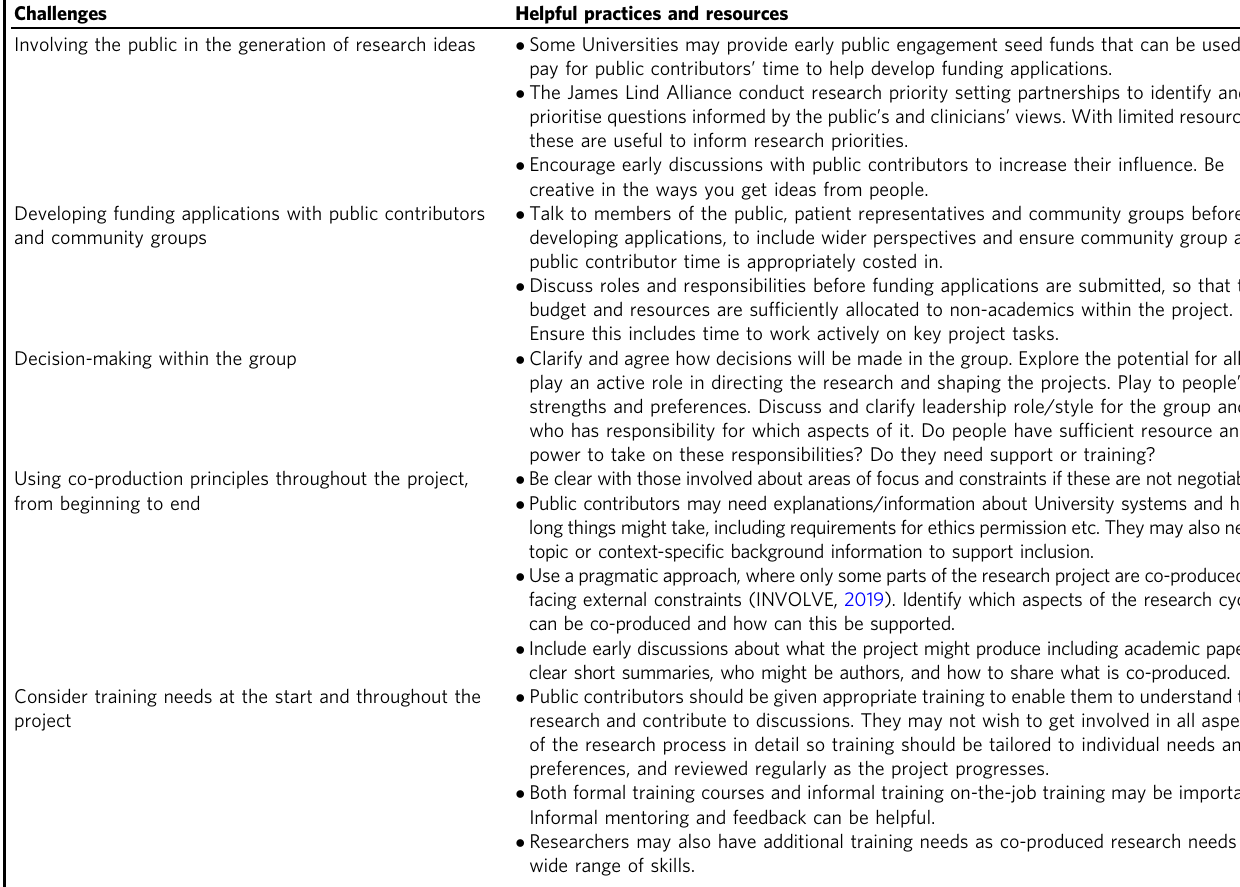
Table 1 Navigating challenges relating to who is involved, and